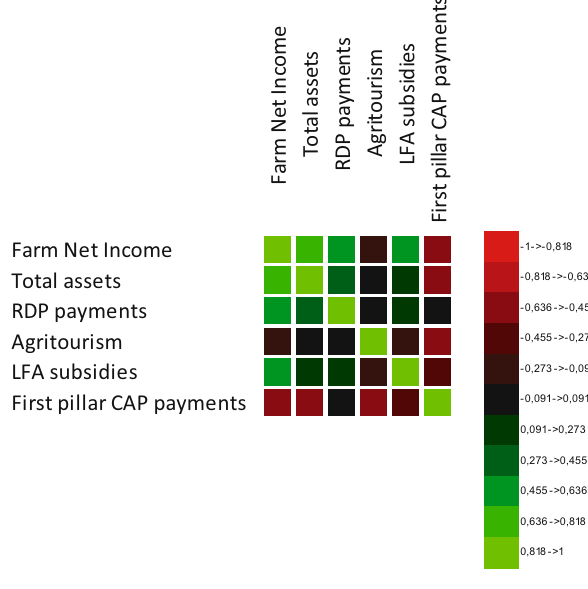
Figure 5: Main correlations in all investigated variables for all Romanian regions ( source: author ’ s own elaboration on data available at http://statistici.insse.ro and https://ec.europa.eu/ agriculture/rica/database/database_en.cfm )